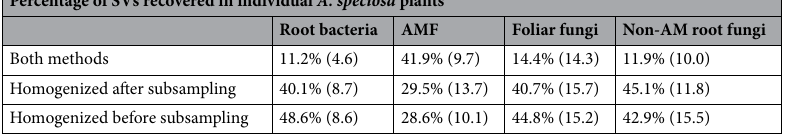
Percentage of SVs recovered in individual A. speciosa plants Both